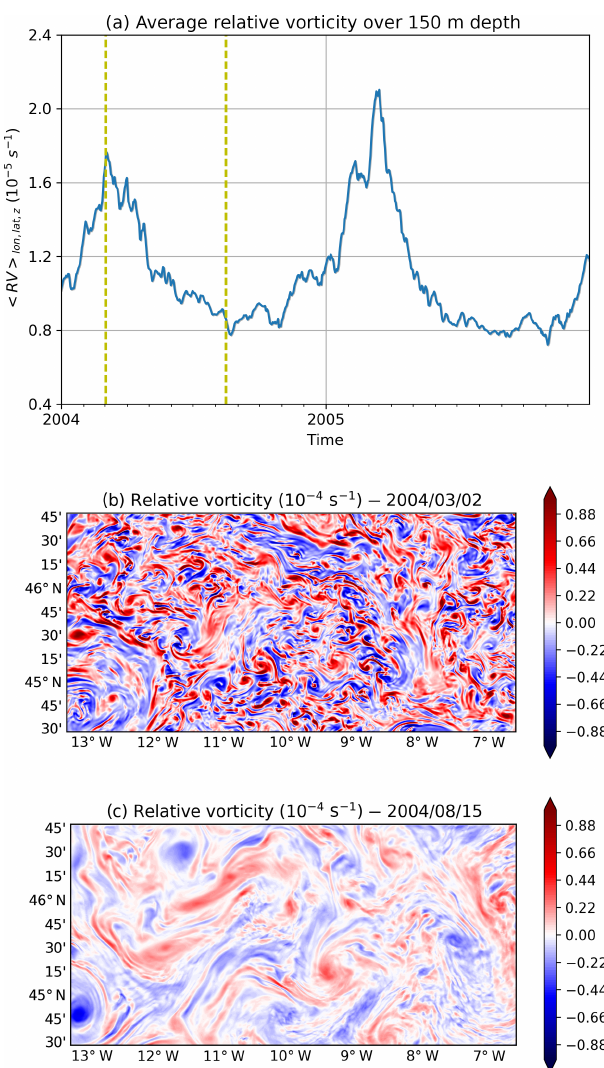
Figure 10. Relative vorticity averaged over 150m depth and spa- tially averaged for the years 2004 and 2005 (a) . Map of the surface relative vorticity for 2 March 2004 (b) and 15 August 2004 (c) .